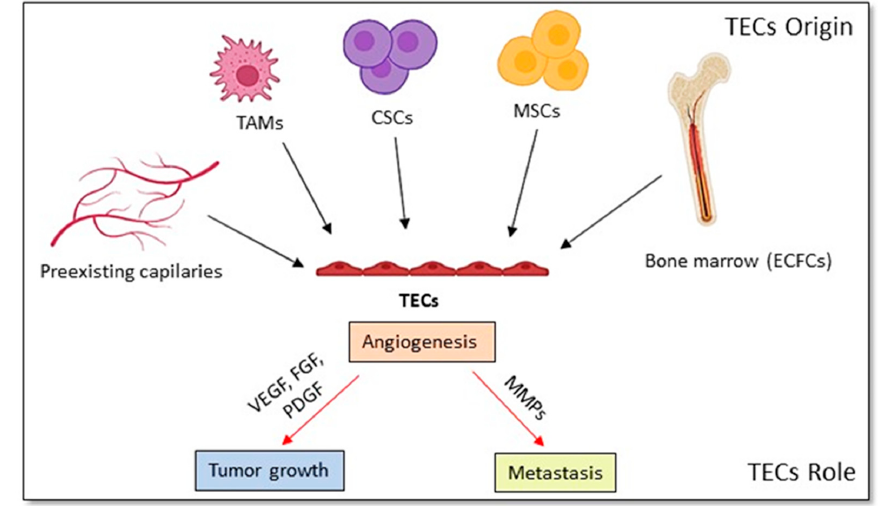
Figure 4. The origin of TECs and their roles in the TME.